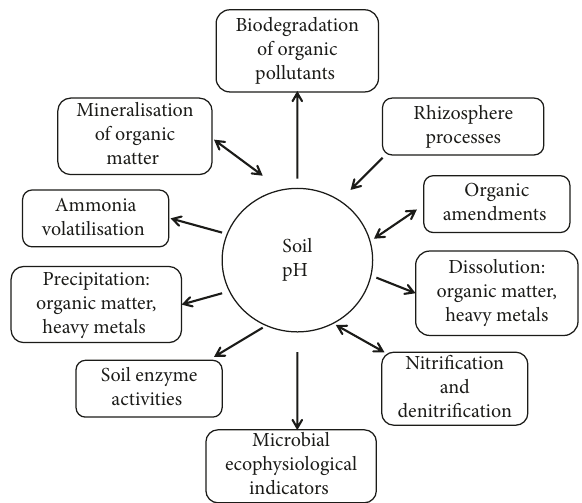
Figure 1: Some biogeochemical processes and their relations with soil